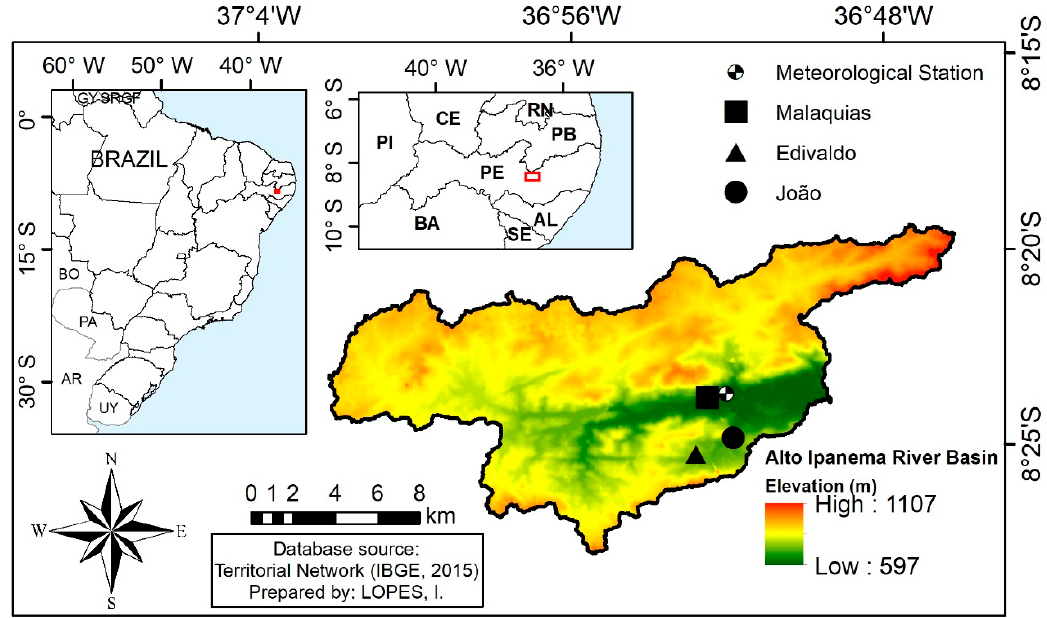
Figure 1. Location of the study sites of Malaquias, Edivaldo, and João in Alto Ipanema River Basin, Pernambuco State, Brazil.